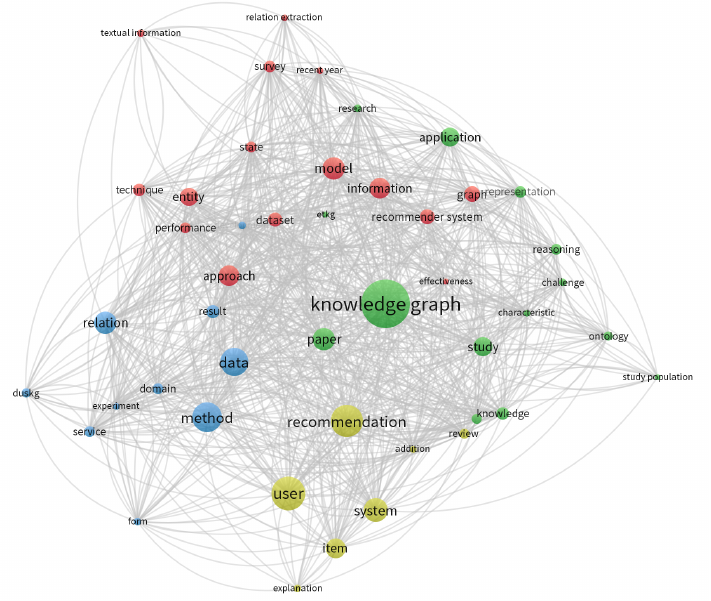
Figure 4. Terms network built from titles and abstracts of the selected